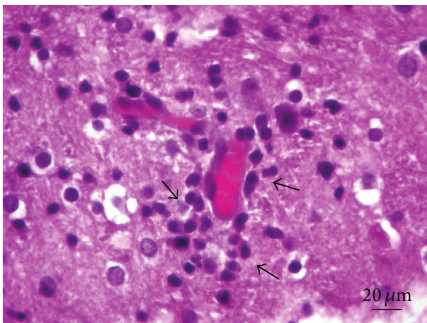
Figure 1: Brain. Lesion Grade I. Vascular congestion and discrete lymphocytic cuffing (arrows). Hematoxylin and eosin.